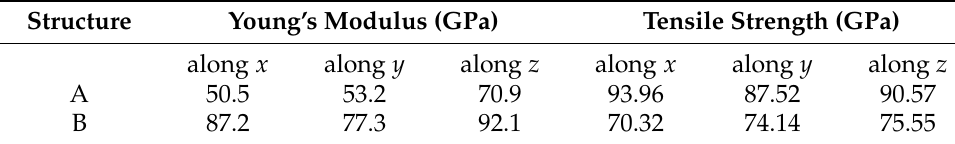
Table 2. Young’s modulus and tensile strengths of the crumpled graphene